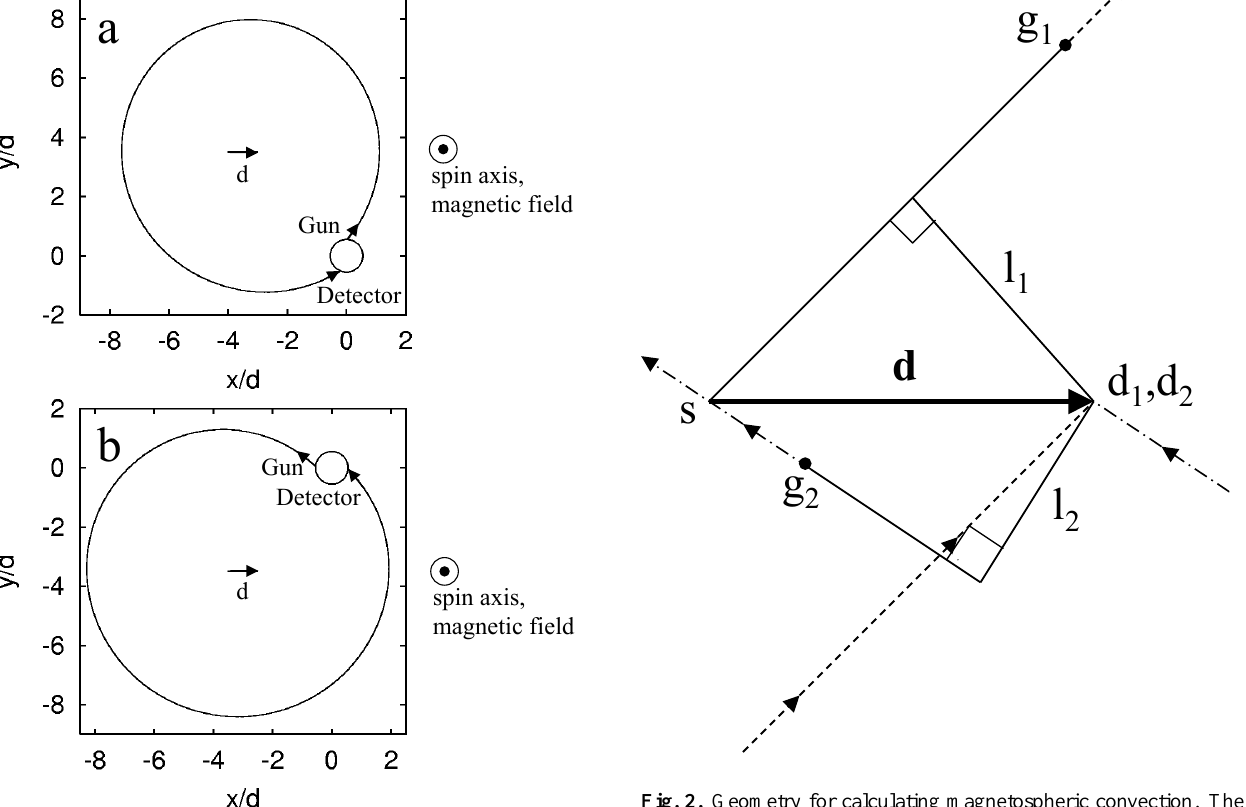
Fig. 2. Geometry for calculating magnetospheric convection. The plane shown is perpendicular to the magnetic field. Electron beams are emitted from the locations g 1 and g 2 . After about one cyclotron period, the beams are detected at the locations d 1 and d 2 . The loca- tions of the guns and detectors are moved in parallel so that d 1 and d 2 are